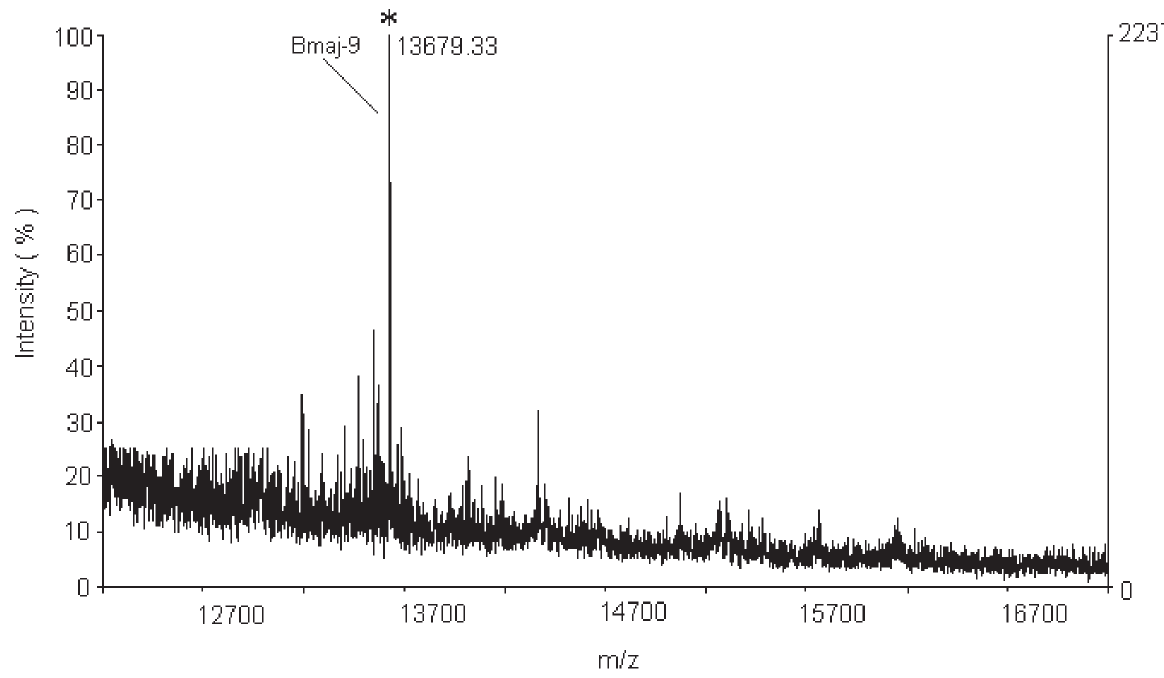
Figure 2. Bmaj-9 mass (13679.33 Da) determined by MALDI-TOF mass spectrometry.